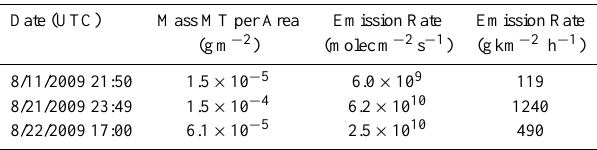
Table 2. Summary of estimated storm-induced monoterpene emis- sions at Thompson Farm. Mass MT per area is the grams of monoterpenes per square meter of ground area, and the correspond- ing emission rate of monoterpenes are in (molecm − 2 s − 1 ) and (gkm − 2 h − 1